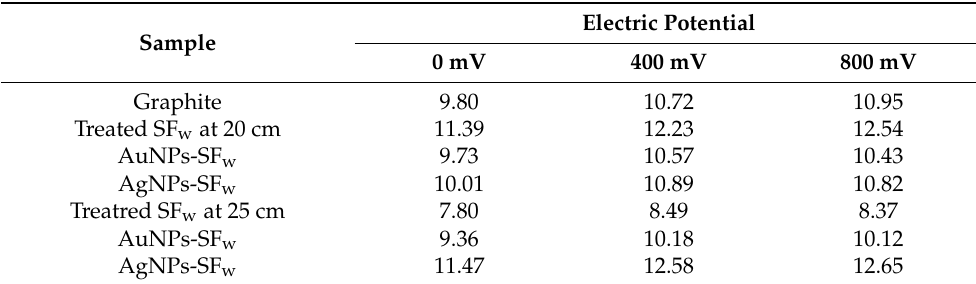
Table 4. Impedance values obtained at different DC electric potentials for the different membranes evaluated by EIS obtained at a frequency of 2 Hz.